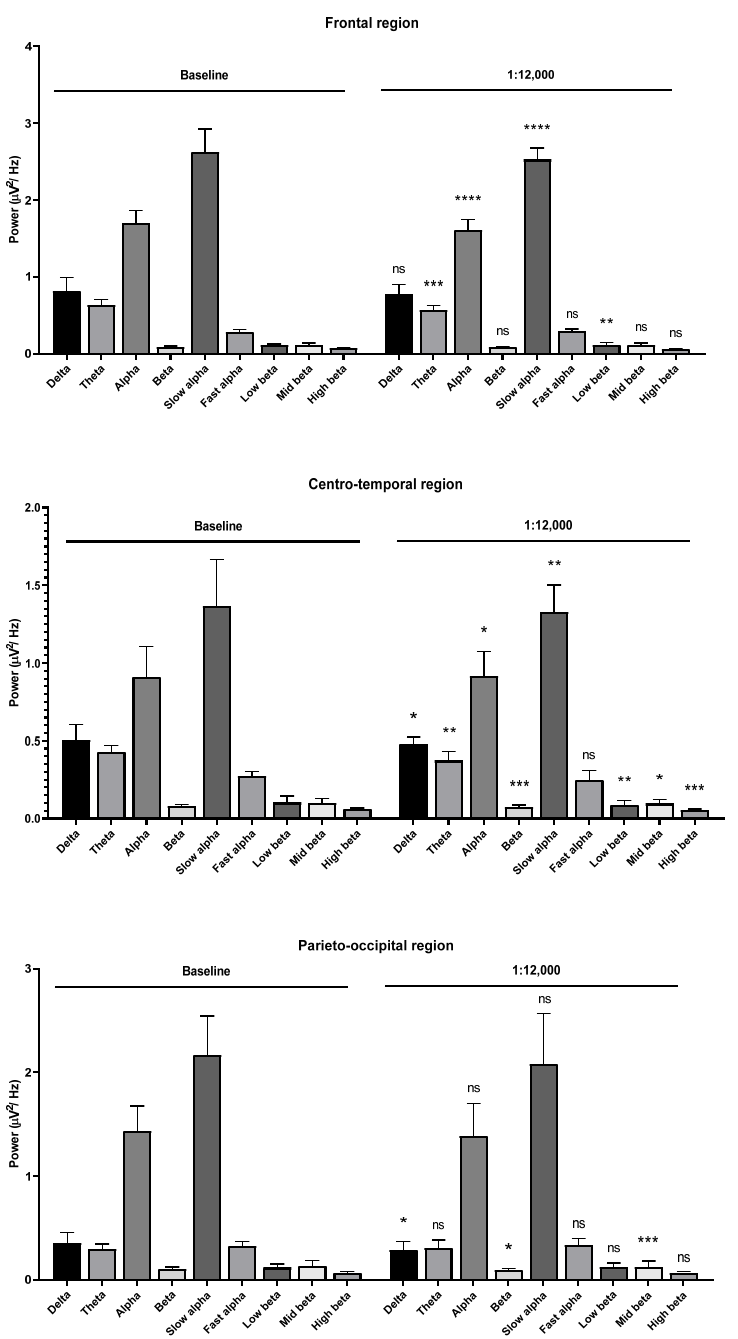
Figure 9. Effects of garlic oil inhalation at a 1:12,000 dilution on the delta, theta, alpha, beta, slow alpha, fast alpha, low beta, mid beta, and high beta wave powers: ( upper ) frontal region; ( middle ) centro-temporal region; ( lower ) parieto-occipital region. p value: not significant (ns) ≥ 0.05, * < 0.05, ** < 0.01, *** < 0.001, and **** < 0.0001.